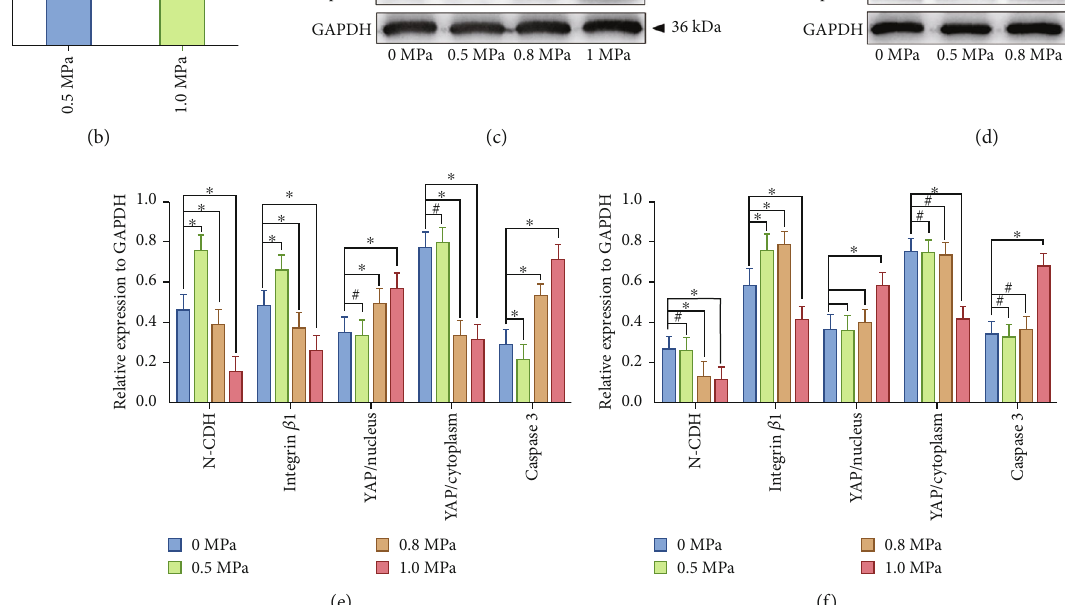
Figure 7: E ff ect of hydrostatic pressure on YAP/TAZ pathway-mediated apoptosis of the rabbit notochordal NP and fi brocartilaginous inner AF: (a) YAP/TAZ complex (green) fl uorescent staining of the fi brocartilaginous inner AF under low-loading (0.5 MPa) or high-magnitude (1.0 MPa) physiological hydrostatic pressure (200x); (b) statistic analysis of YAP/TAZ complex nucleus/cytoplasm distribution; (c) western blotting analysis of the expression levels of N-CDH, integrin β 1, and YAP/TAZ-mediated apoptosis markers (YAP/nucleus, YAP/cytoplasm, Caspase3) of the notochordal NP under graded hydrostatic pressure; (d) western blotting analysis of the expression levels of N-CDH, integrin β 1, and YAP/TAZ-mediated apoptosis markers (YAP/nucleus, YAP/cytoplasm, Caspase3) of the fi brocartilaginous inner AF under graded hydrostatic pressure; (e) statistic analysis of the western blots of the notochordal NP under graded hydrostatic pressure; (f) statistic analysis of the western blots of the fi brocartilaginous inner AF under graded hydrostatic pressure. ∗ P < 0 : 05 . # P > 0 : 05 . Scale bar = 100 μ